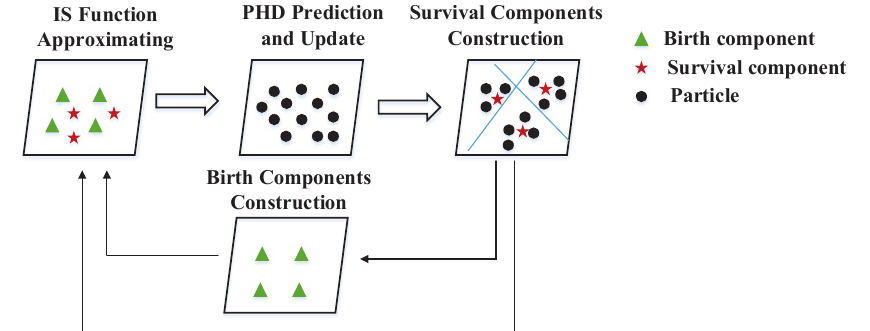
Figure 1. Framework of the F-CISMC-PHD approach. In the IS function Approximating step, we utilize the survival and birth components to approximate the IS functions. Then the predicted particles are generated and updated in the PHD prediction and update step to achieve the posterior